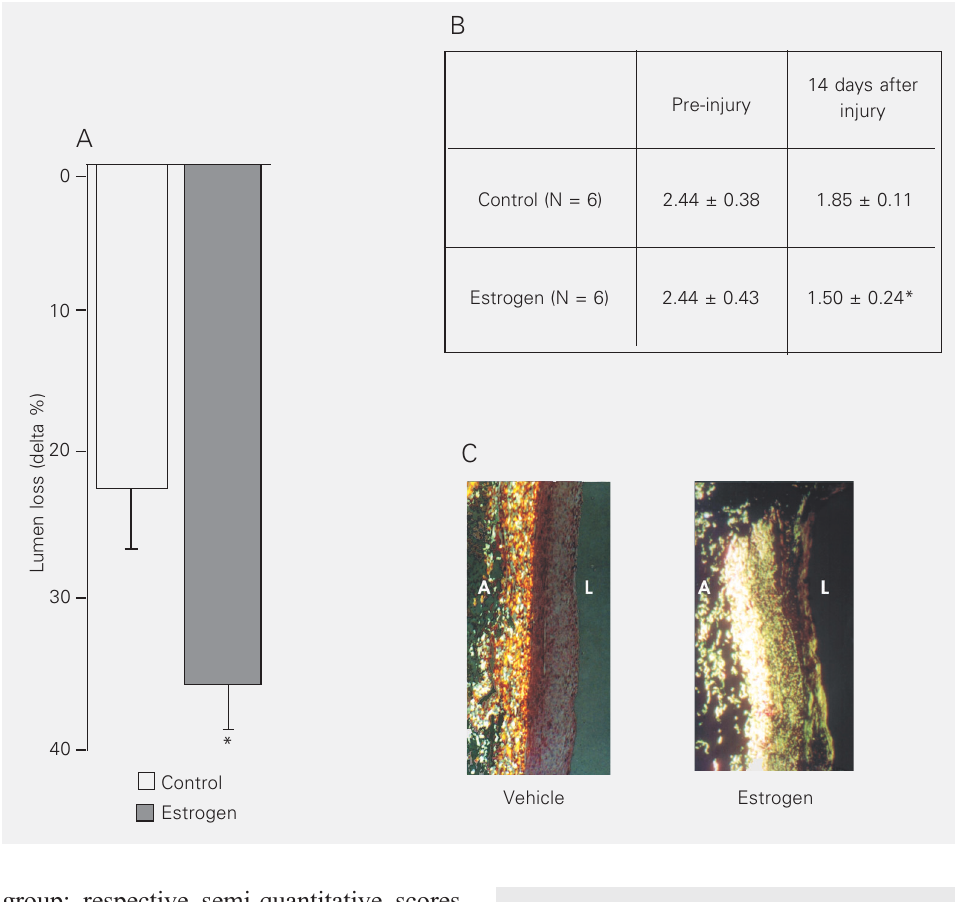
Figure 2. Densitometric analysis of RT-PCR-amplified mRNA lev- els for eNOS (four left columns) and iNOS (four right columns) in uninjured control or 14 days af- ter balloon injury of iliac arteries from rabbits treated with vehicle (open columns) or estrogen (filled columns). eNOS = endo- thelial nitric oxide synthase; iNOS = inducible nitric oxide synthase.